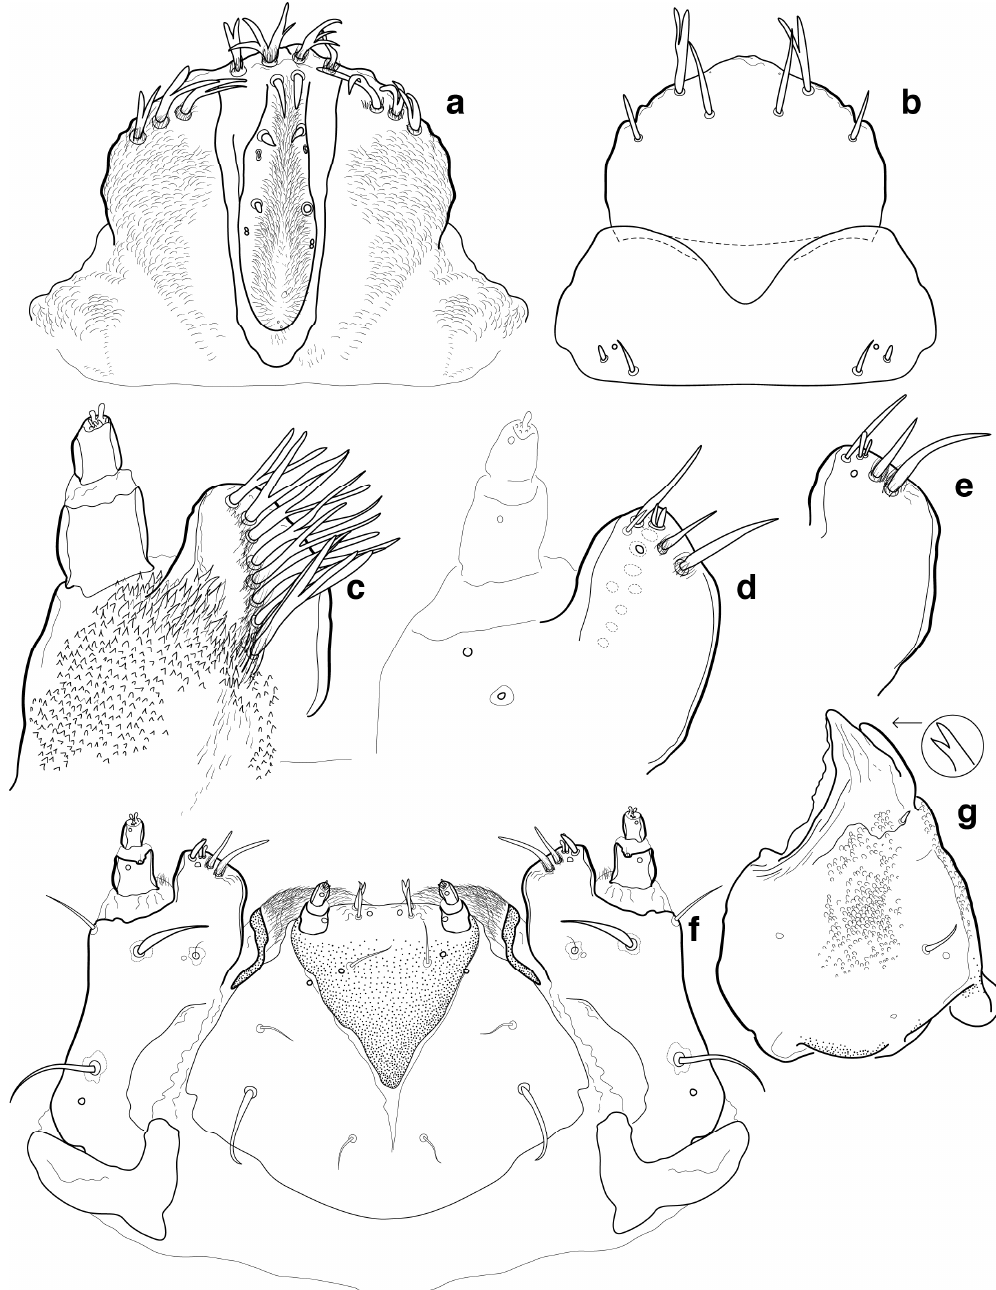
Figure 57. Cosmopolites sordidus mouthparts: ( a ), epipharynx; ( b ) clypeus and labrum; ( c ) detail of mala and maxillary palp, dorsal view; ( d ) detail of mala and maxillary palp, ventral view; ( e ) detail of mala and maxillary palp, opposite side, ventral view; ( f ) labio-maxillary complex, ventral view; and ( g ) mandible and detail of cusps.